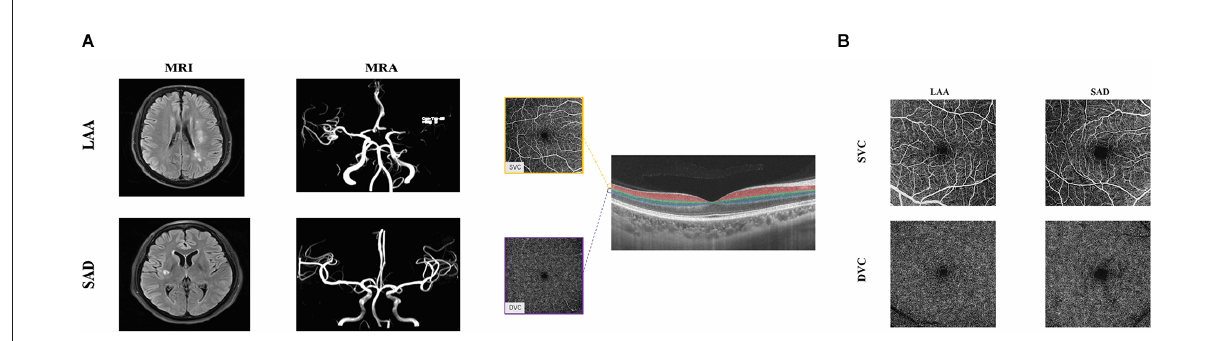
FIGURE1 Neuroimaging and illustrative images of the retinal microvasculature network in LAA and SAD. Panel (A) shows the MRI and MRA images both SAD and LAA. Panel (B) shows the segmentation of the retinal microvasculature. En face angiograms of the superficial vascular complex (SVC) and deep vascular complex (DVC) are displayed. The right panel shows angiograms of a patient with LAA and SAD. The SVC microvascular was larger in LAA compared to SAD. LAA, large artery atherosclerosis; SAD, small artery